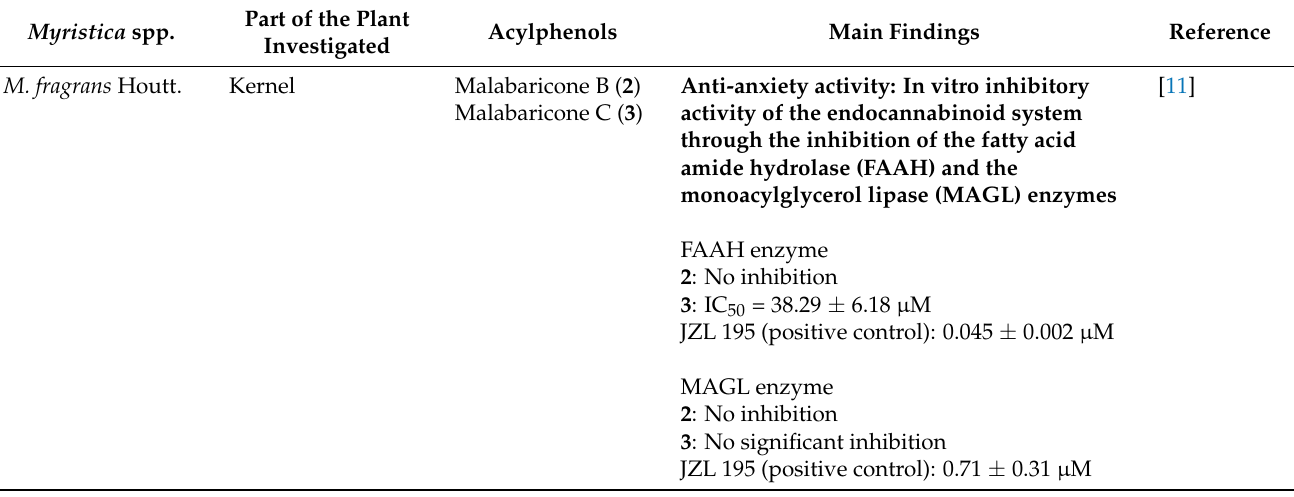
Table 10. The anti-anxiety activity of acylphenols from the genus Myristica . Myristica spp.